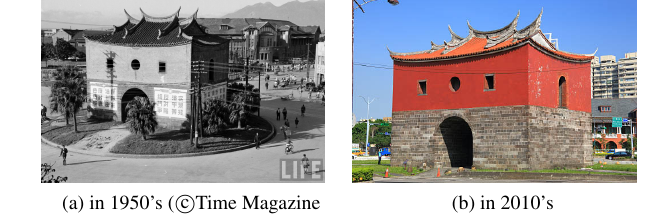
Figure 5. Photographs of the Taipei City Wall North Gate taken in the 1950’s and modern